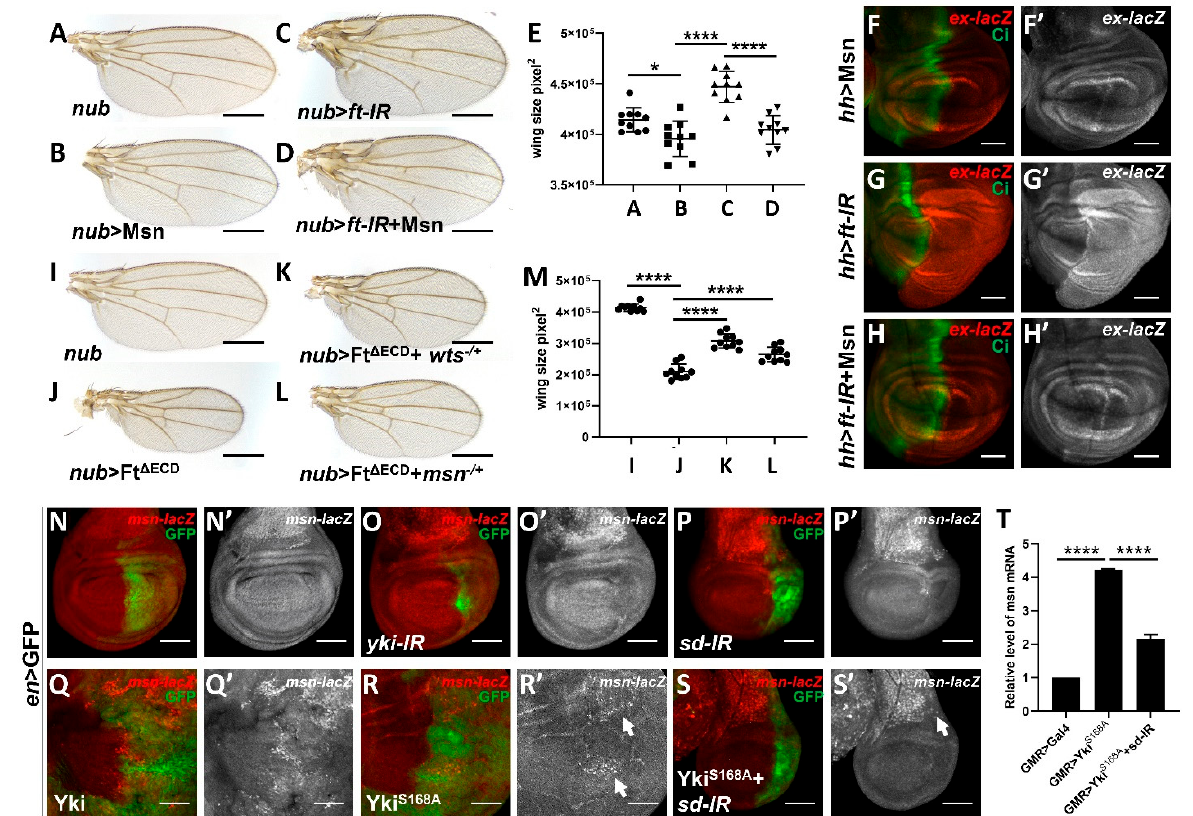
Figure 4. Msn acts downstream of protocadherin Fat (Ft) in modulating Hippo signaling. ( A – E ) Light micrographs of Drosophila adult wings. Compared with control ( A ), Msn overexpression significantly impedes ft knockdown-induced overgrowth phenotype ( C and D ); note that overexpression of Msn alone mildly reduces wing size ( B ). ( E ) Quantification of wing size in ( A – D ). ( F – H and F’ – H’ ) Fluorescence micrographs of wing discs are shown. Msn overexpression